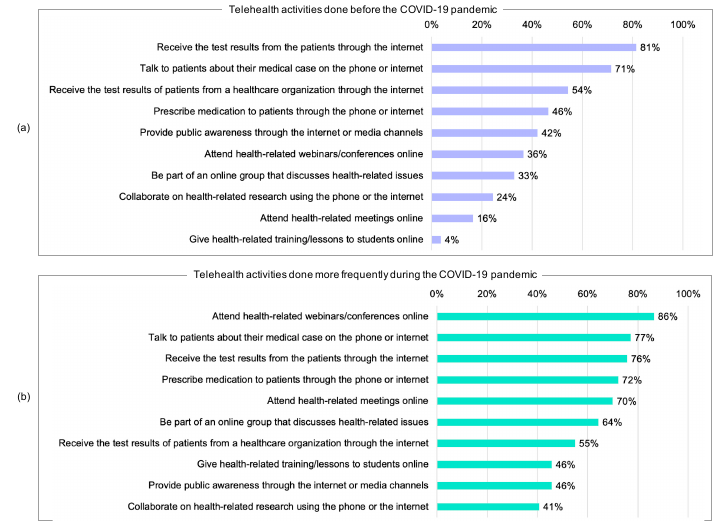
Figure 2. ( a ) Telehealth activities done before the COVID-19 pandemic; ( b ) telehealth activities done more frequently during the COVID-19 pandemic.